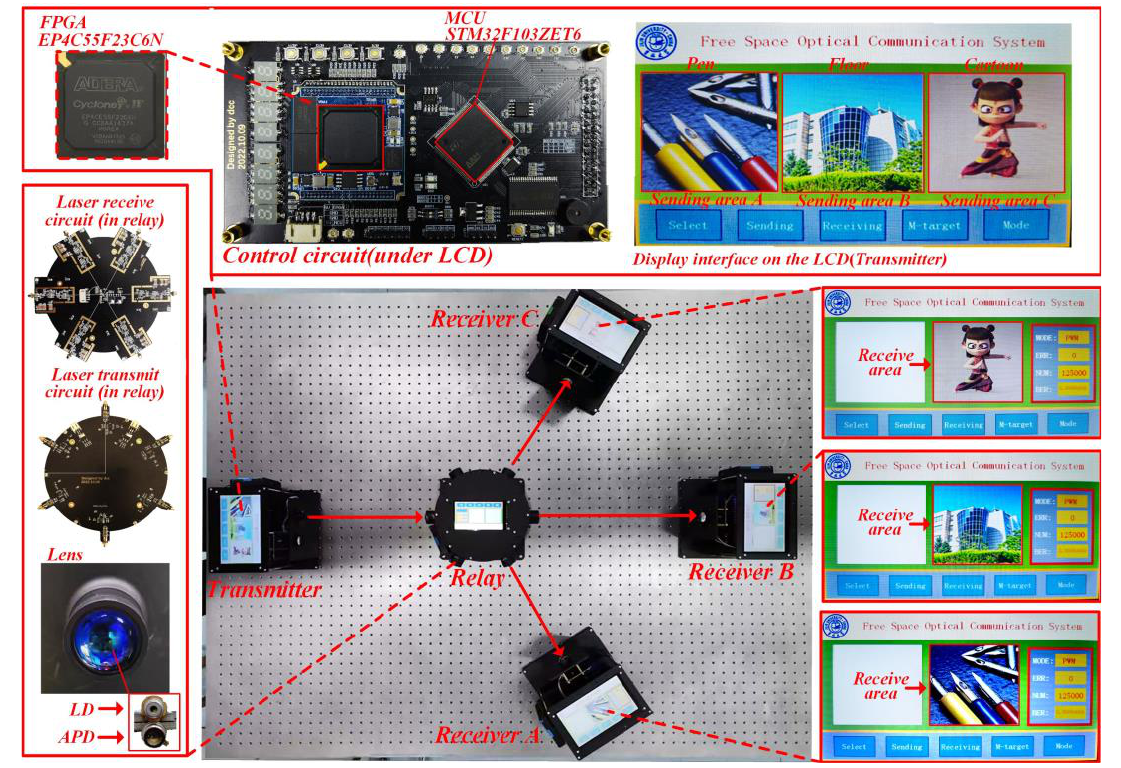
Figure 11. Test diagram of the free-space optical communication system.